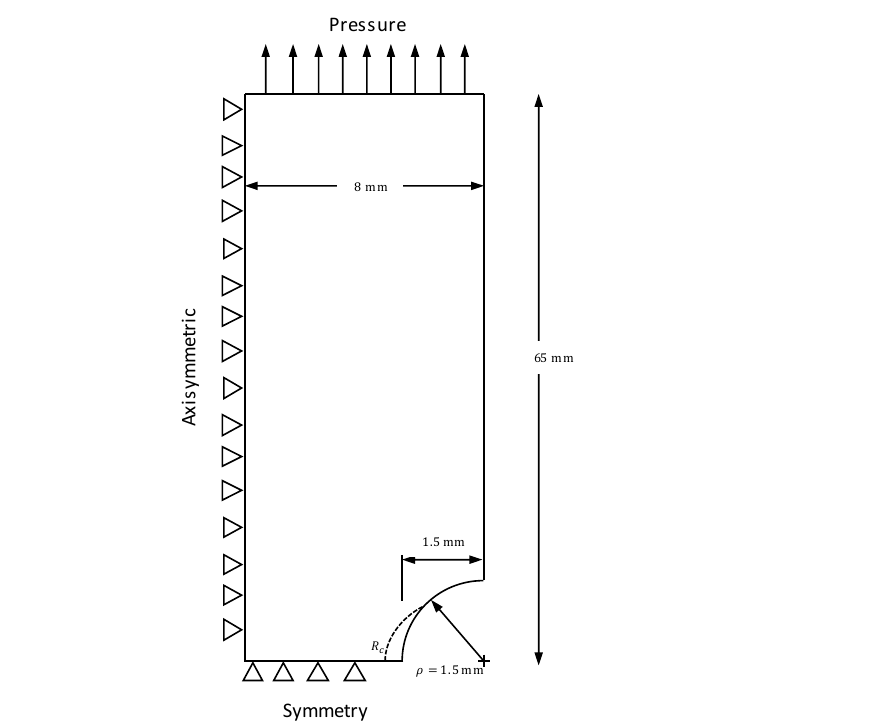
Figure 8. Finite element results. ( a ) Normal stress along the y -direction. ( b ) Elastic strain energy in the control volume. 5. Results and Discussion The fatigue results for U-notched specimens obtained in this investigation are listed in Table 2. In addition, the results for V-notched specimens obtained by Albinmousa et al. [37] are also listed in the table for comparison. The nominal and net section stresses in the table are calculated at the gripping, 𝐷 = 16 mm, and net, 𝑑 = 13 mm, sections, respec- tively.